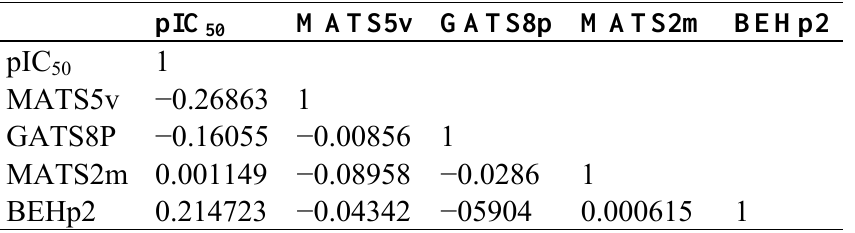
Table 10. Correlation matrix for MLR